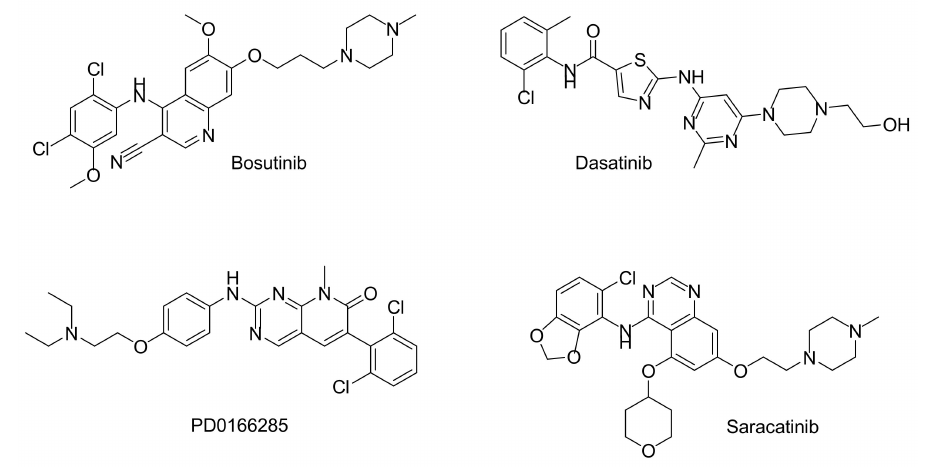
Figure 6. Chemical structures of potent PKMYT1